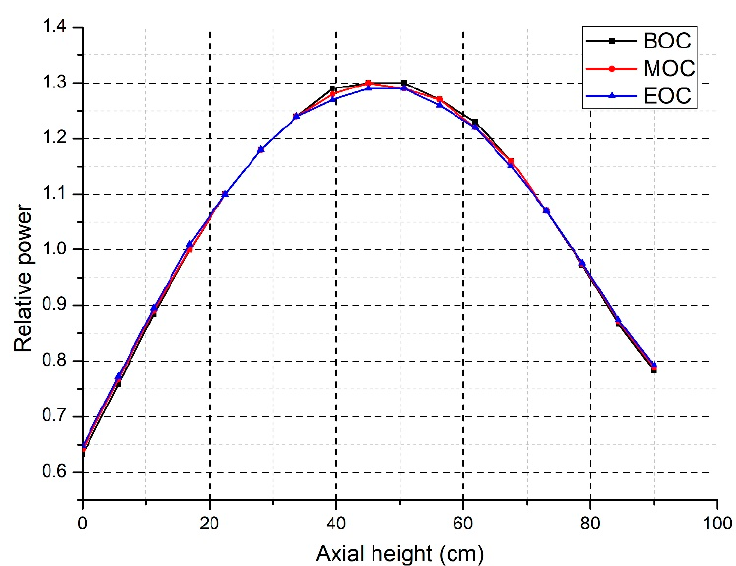
Figure 7. Axial power distribution of the ARO core from bottom to top, at BOC, MOC and EOC.